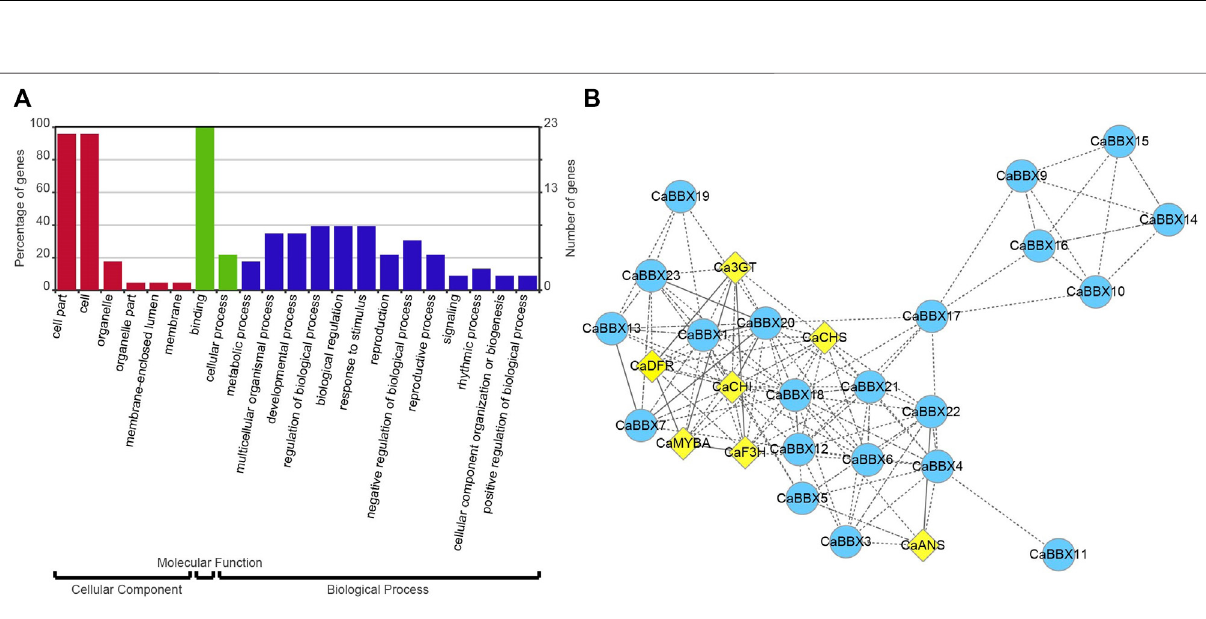
Frontiers in Genetics |